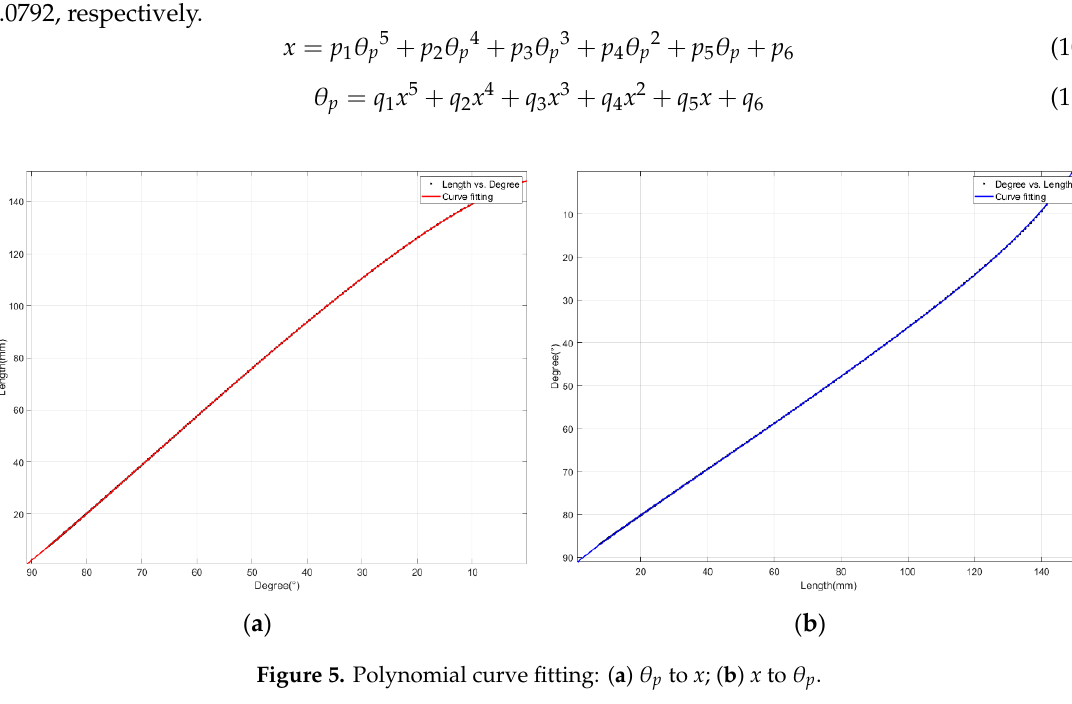
Table 1. Coefficient of 𝜃 (cid:3043) and 𝑥 polynomial.